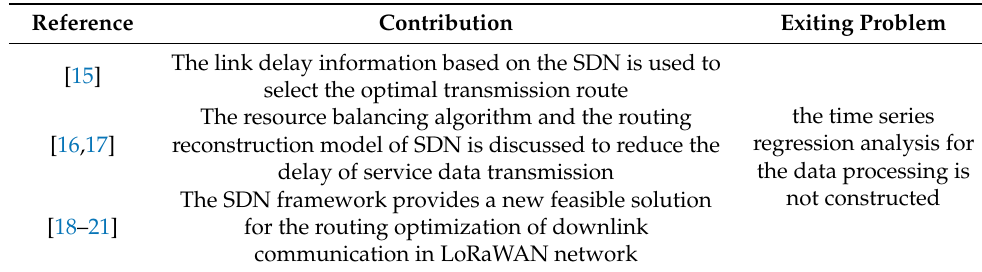
Table 1. The related work of the